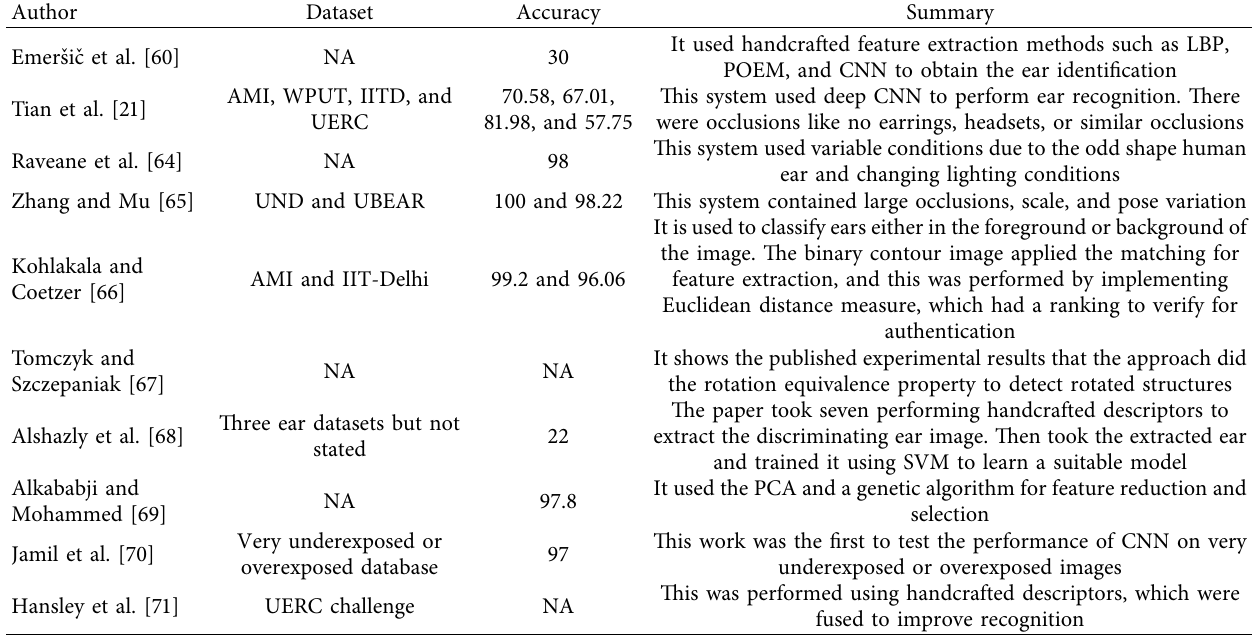
Table 5: Summary of the ear algorithms using